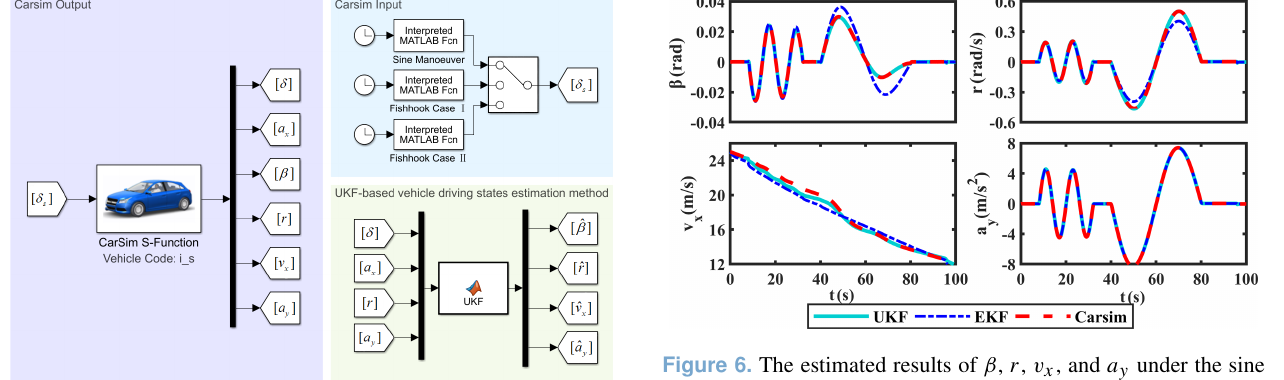
Figure 6. The estimated results of β , r , v x , and a y under the sine manoeuver test.